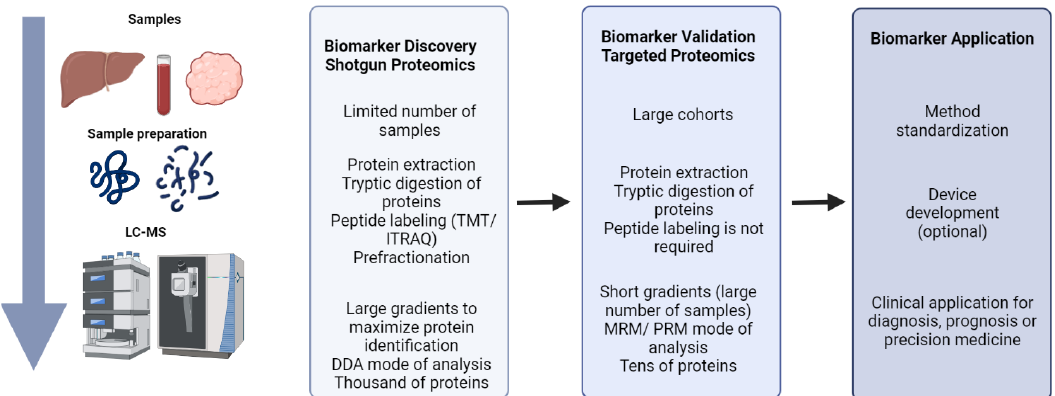
Figure 2. Proteomics workflow for biomarkers discovery. Sample collection, storage, protein extraction, and processing are essential steps for proteomics analysis. Shotgun analysis allows for the identification, quantification, and characterization of thousands of proteins; it is the ideal procedure for biomarker discovery. Once identified, candidates must be confirmed in large cohorts to assess their discriminatory capacity with sufficient sensitivity and specificity; this phase demands high sample throughput analytical strategies, such as targeted methods (MRM, PRM) to quantify the panel of selected proteins. Finally, the clinical application may rely on the standardization of the methods and eventually on the development of devices for a straightforward implementation in the clinical routine.